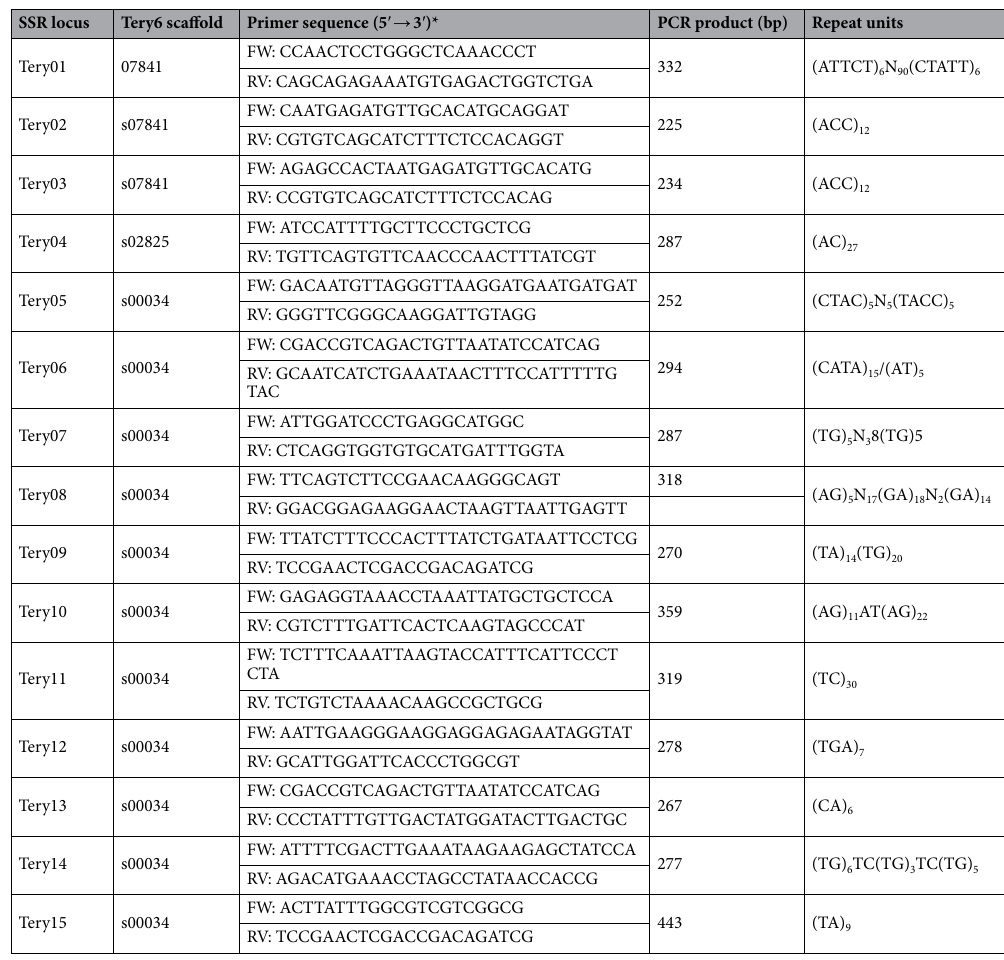
Table 1. SSR loci developed in Trioza erytreae. * FW forward; RV